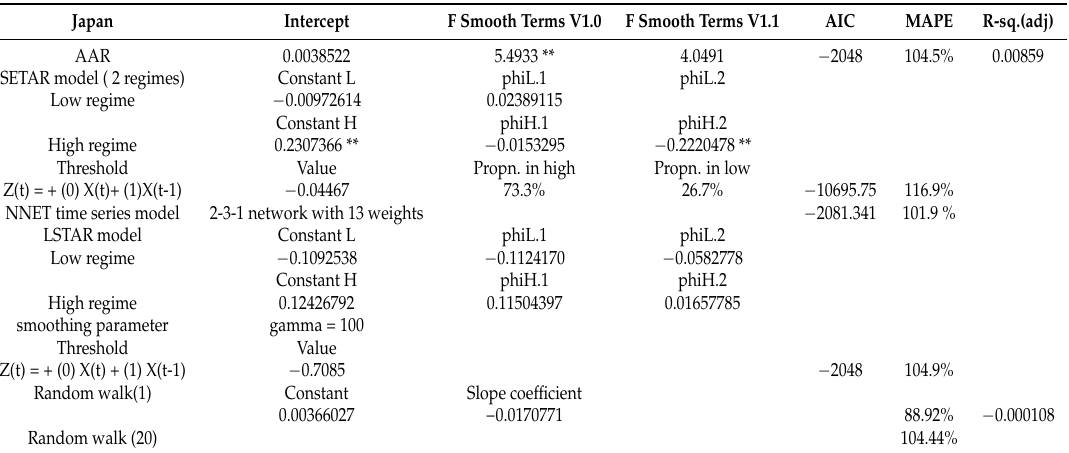
Table 6. Non-linear